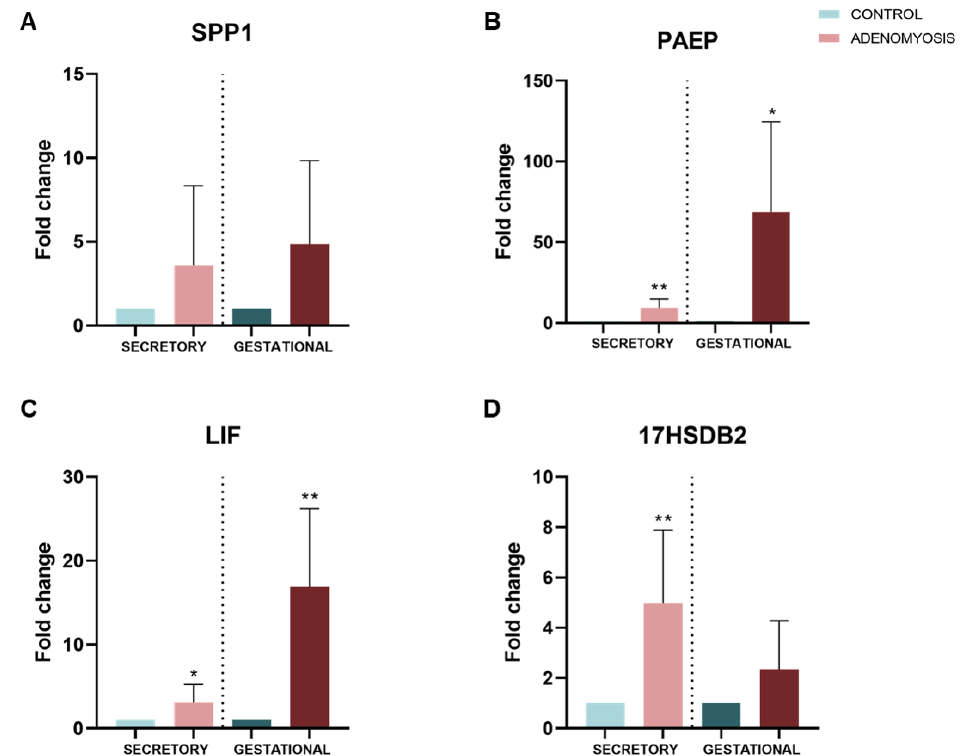
Figure 4. Gene expression of secretory and gestational endometrial biomarkers involved in regulation of implantation and placentation. ( A ) SPP1 , ( B ) PAEP , ( C ) LIF , and ( D ) 17 β HSD2 gene expression in Adeno and Control secretory and gestational organoids by qRT-PCR. Scale bars are 100 µ m. Endometrium was used as a positive control. * p < 0.05, ** p < 0.01.